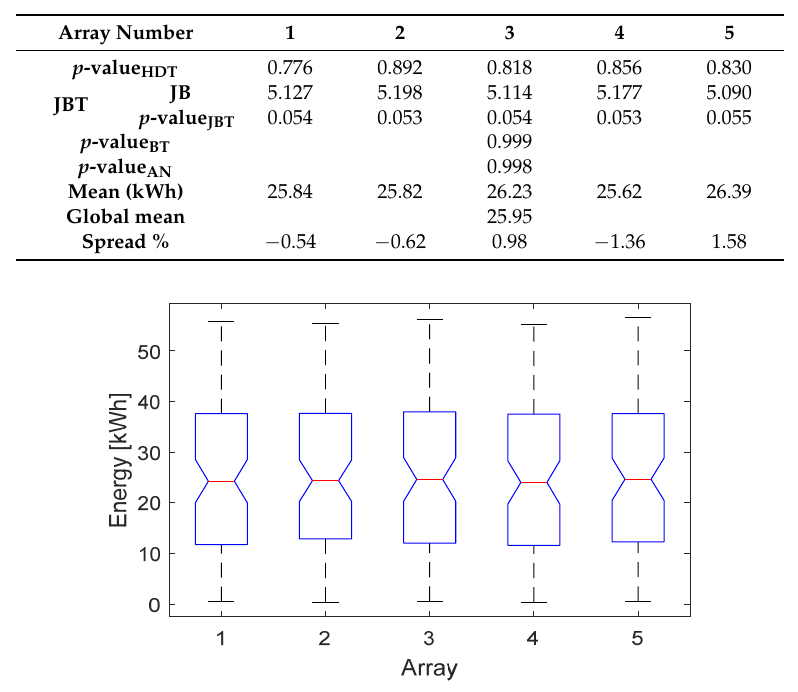
Figure 6. Box plot of K-W test of the five distributions for the three-months analysis (January–March).